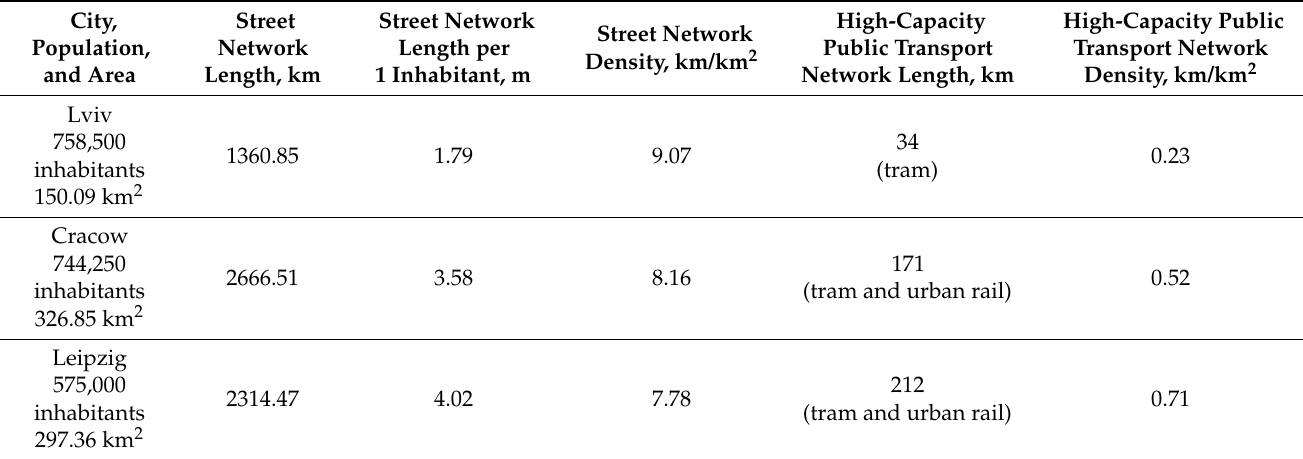
Table 1. Comparative analysis of the street and public transport network parameters